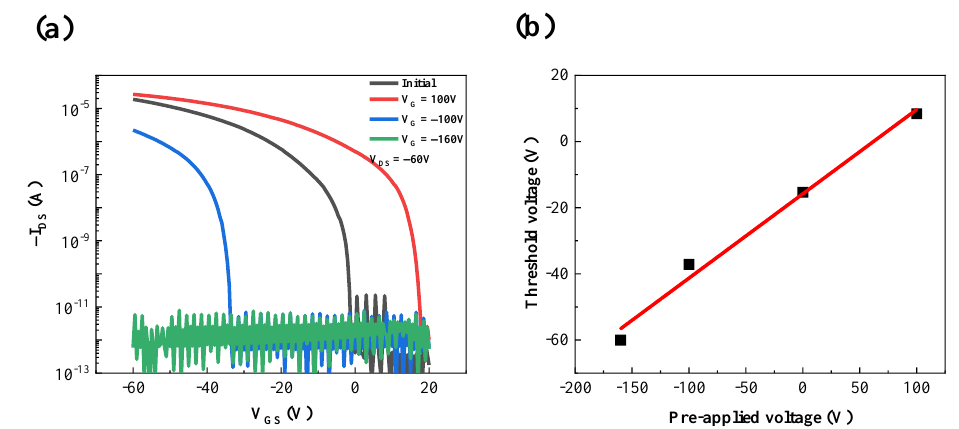
Figure 2. ( a ) Transfer curves at different pre-applied voltages to the gate electrode; ( b ) Threshold voltage shift as a function of pre-applied voltage to the gate